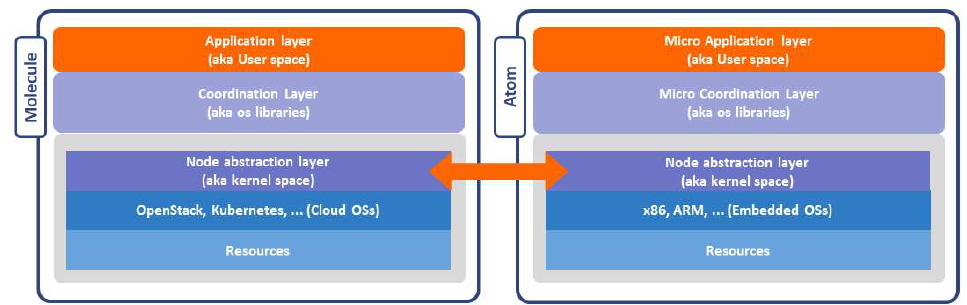
Figure 2. High-level meta-operating system architecture.